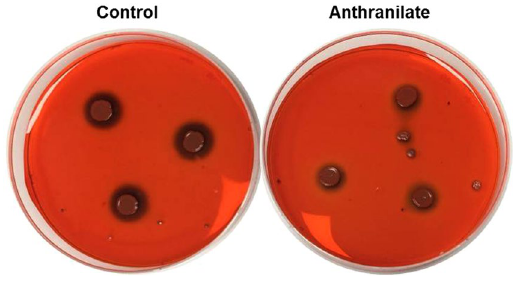
Figure 8. Inhibition of slime production by S. aureus by anthranilate Slime production by S. aureus was assessed by Congo red staining. S. aureus overnight culture (3 μ l) was inoculated on a CRA plate containing 0.1 mM anthranilate and incubated at 37 °C for 24 hours. Slime production was visualized as a dark red around colonies.